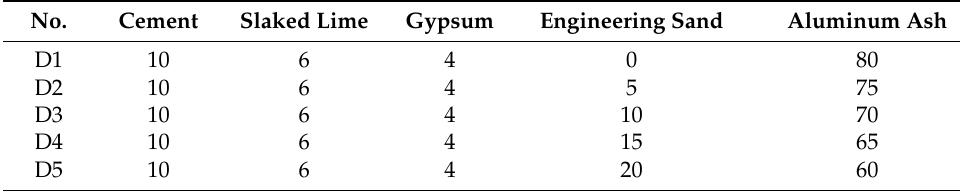
Table 5. Engineering sand and aluminum ash mix design.